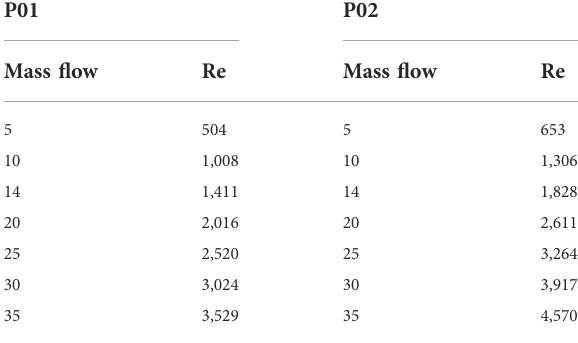
TABLE 6 Calculated reynolds number at the nostril inlet for variable fl ow